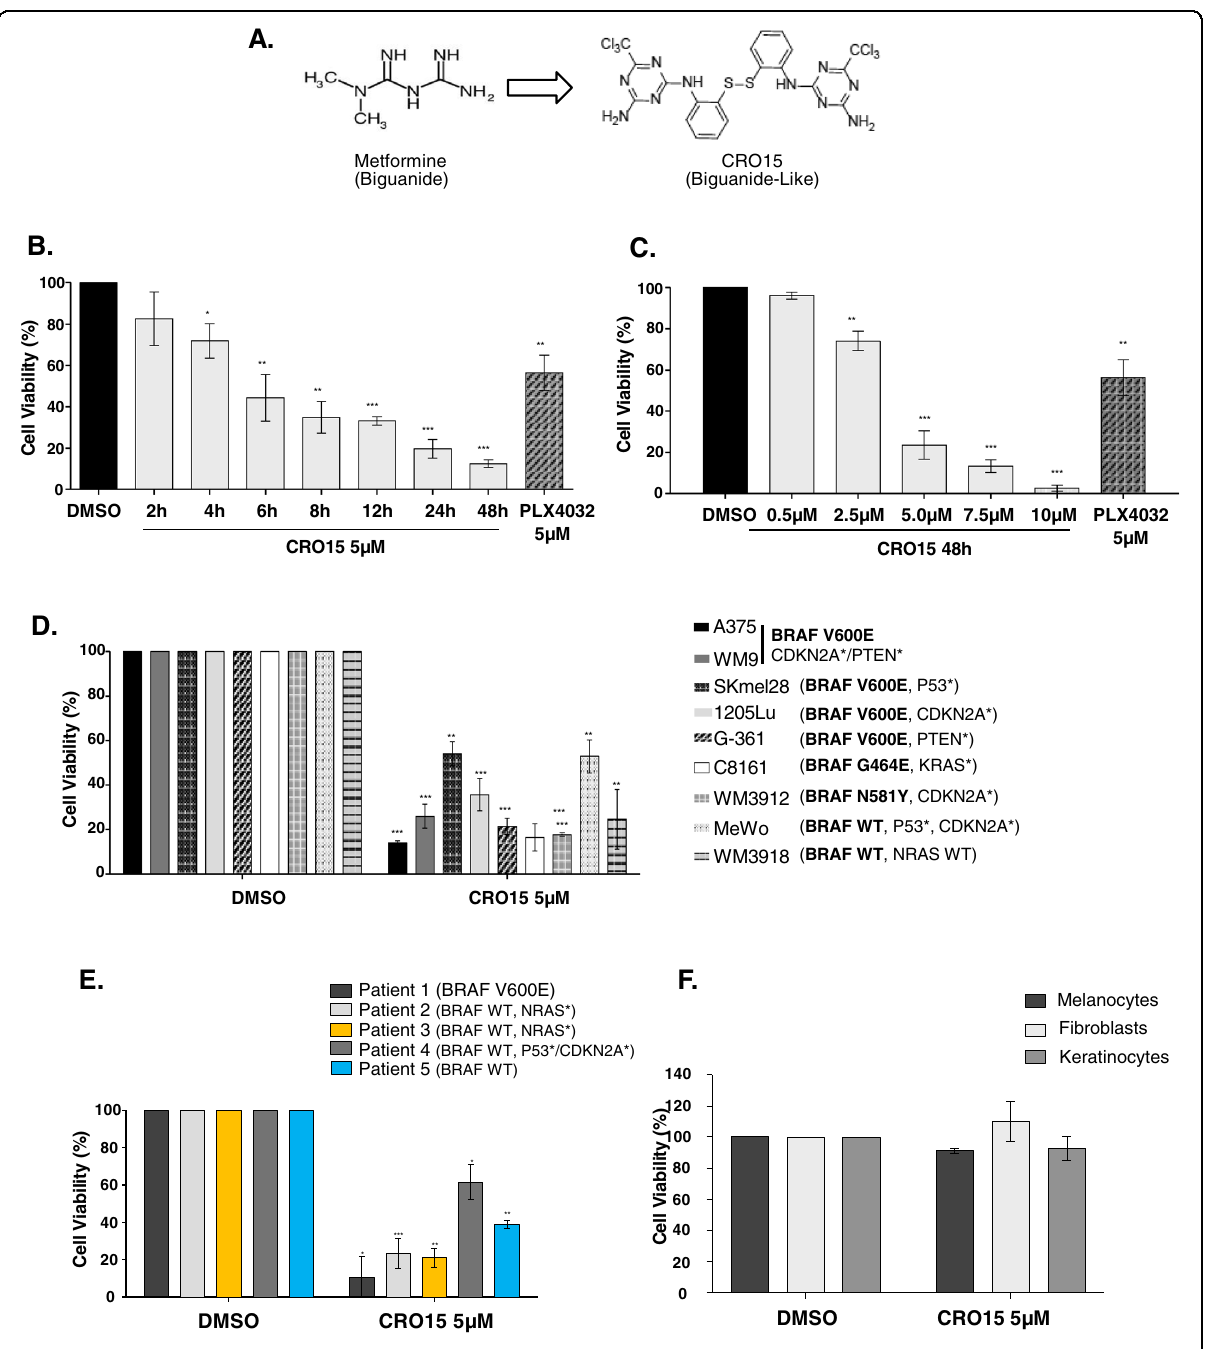
Fig. 1 CRO15 exerts a deleterious effect on melanoma cell viability. A Chemical structure of metformin and CRO15. B – F Cell viability assay using trypan blue exclusion method on B . A375 melanoma cells treated with 5 μ M CRO15 at different times. C A375 melanoma cells were treated with the indicated concentrations of CRO15 for 48 h. D Melanoma cell lines of various genotypes treated with 5 μ M CRO15 for 48 h. E Human melanoma cells freshly isolated from tumors treated for 48 h with 5 μ M CRO15. F Primary human melanocytes, keratinocytes and fi broblasts treated 48 h with 5 μ M CRO15. For B to F , results are expressed as percentages of control and data given as the means ± SEM of three independent experiments performed in triplicate. * p < 0.05; ** p < 0.01; *** p <